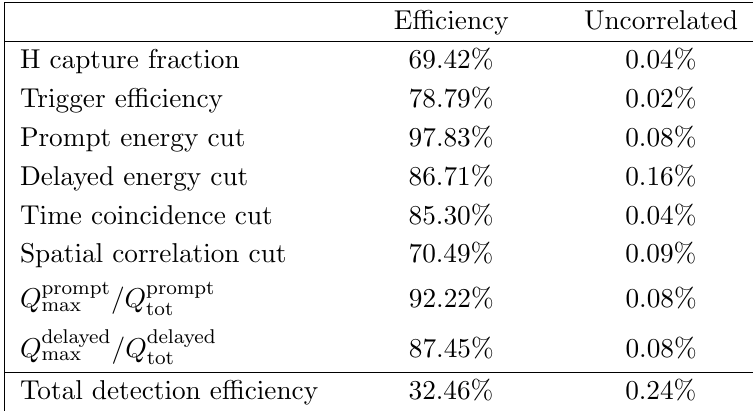
Table 4 . Detection e(cid:14)ciencies and their uncorrelated uncertainties of selection criteria for IBD signal. The e(cid:14)ciency is calculated as the statistical error weighted mean of the near and far measured